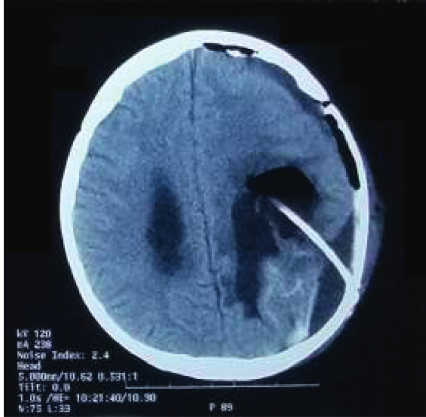
Figure 3: Postoperative simple CT of the